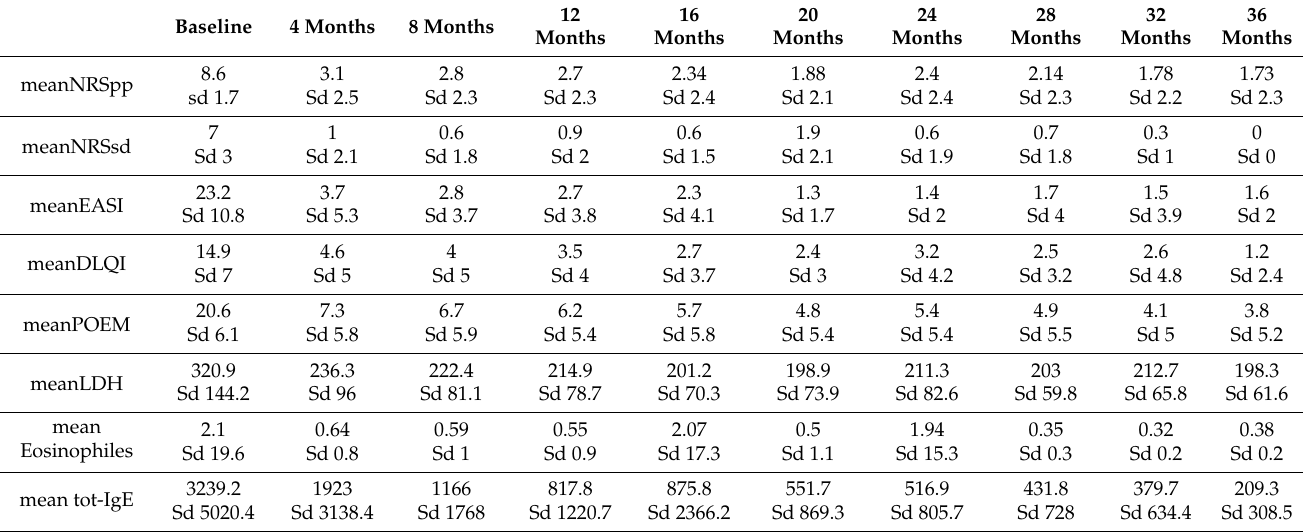
Table 2. Mean reduction in all parameters